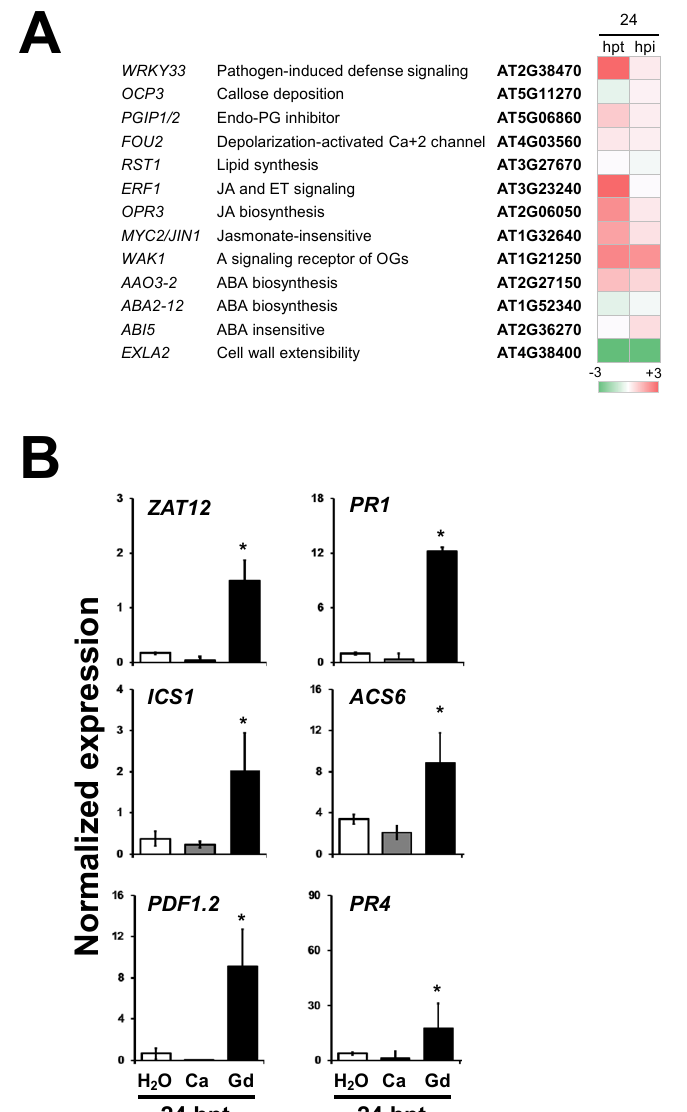
(Figure 8D). Taken together, these results indicated that the Gd-triggered defense response against B. cinerea is mostly dependent on the JA/ET-induced responses.